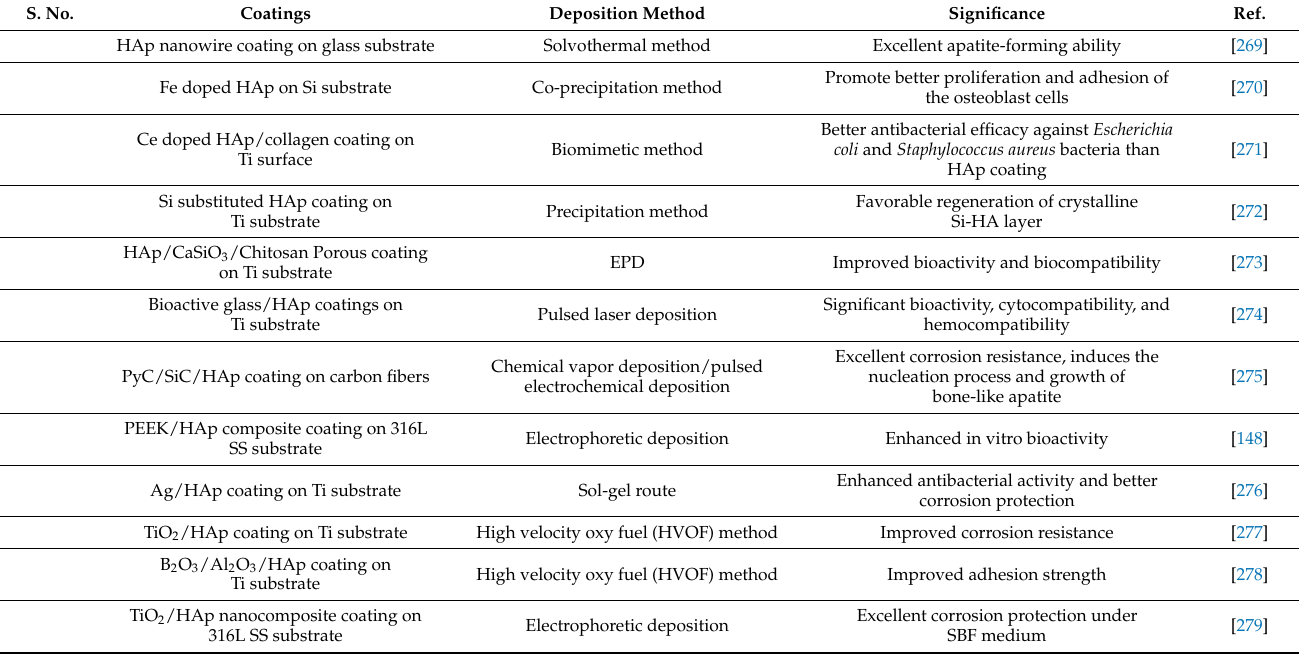
Table 7. Hydroxyapatite and its composites’ coatings for implant